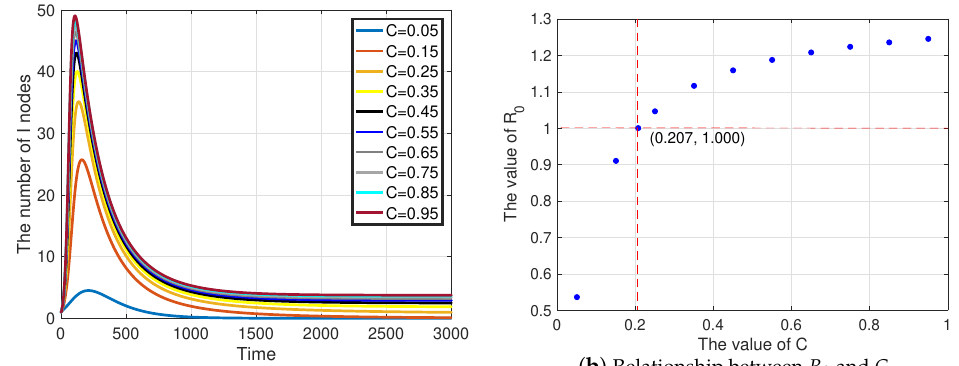
Figure 6. The influence of C